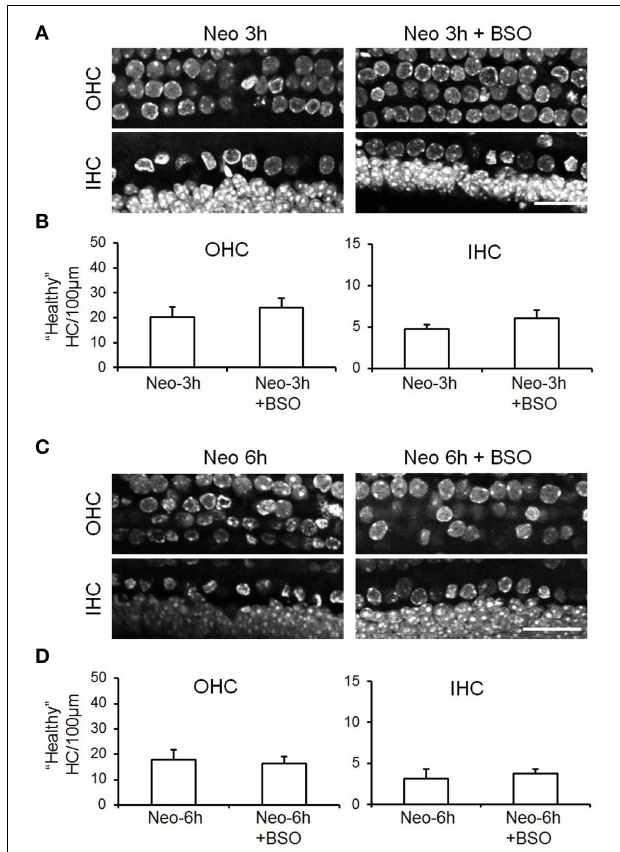
FIGURE 5 | Depletion of cellular GSH does not enhance neomycin induced-hair cell death. (A) Examples of confocal images of DAPI-stained OHC and IHC in cochlear explant cultures treated with neomycin for 3h compared with those that had been pre-incubated with BSO for 18h to deplete GSH before neomycin treatment. (B) Quantification of “healthy” hair cells per 100 µ m length in control or BSO-treated cultures exposed to neomycin for 3h. (C) As above for (A) except that neomycin cultures were fixed after 6h exposure to neomycin. (D) Quantification of “healthy” hair cells per 100 µ m length in control or BSO-treated cultures exposed to neomycin for 6h. Data are presented as mean ± SEM. N for Neo-3h (7), Neo-3h + BSO (7), Neo-6h (6) Neo-6h + BSO (8). Student’s t -test’s revealed no significant differences. Scale bar: 20 µ